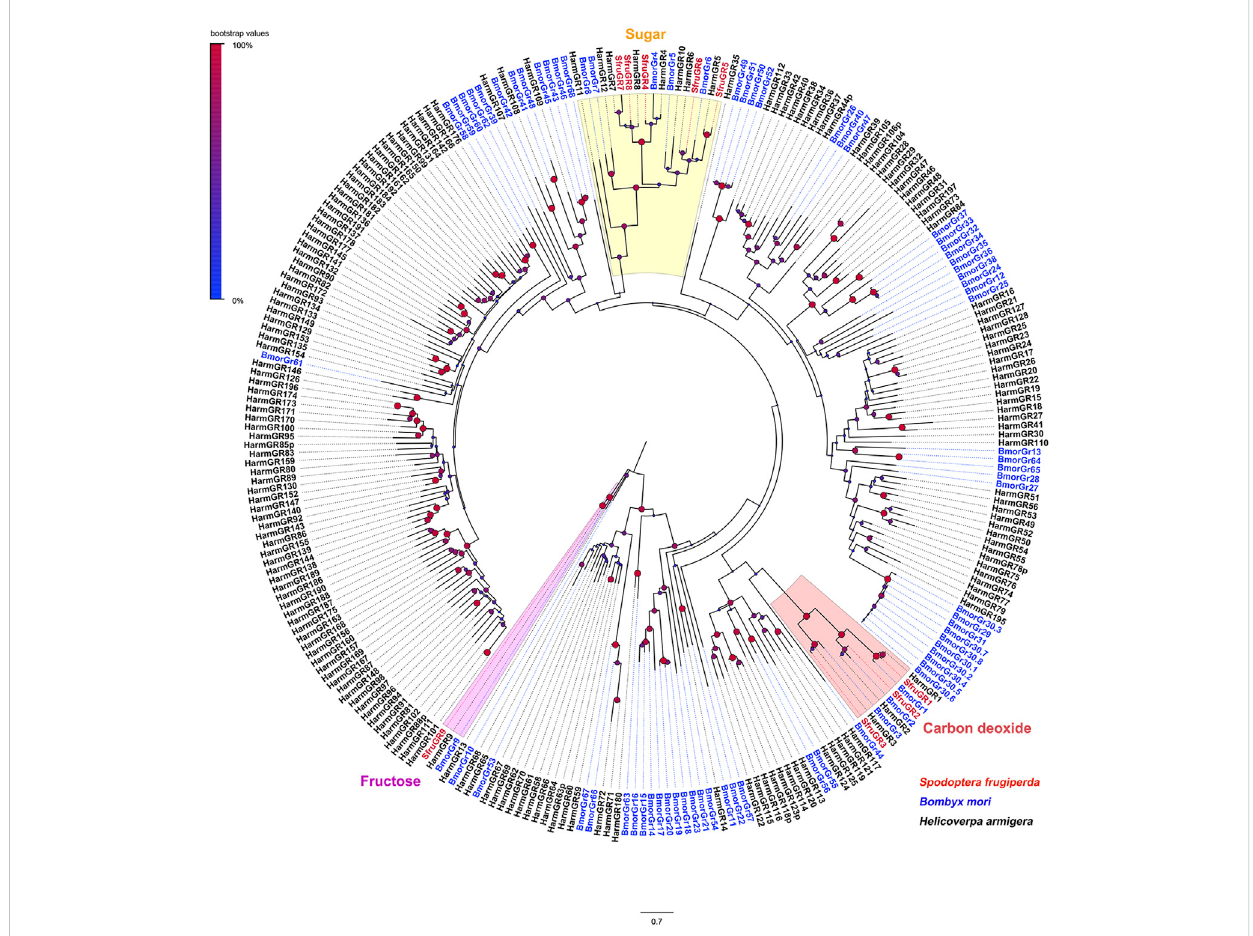
FIGURE 2 Neighbor-joining tree constructed with candidate GRs from S. frugiperda and homologs from H . armigera and B . mori . The tree was rooted by the GR9 orthologs. Node support was estimated with 1000 bootstrap replicates, and bootstrap values were displayed with circles based on the scale indicated at the top left. The scale bar at the bottom indicates the branch length in proportion to amino acid substitutions per